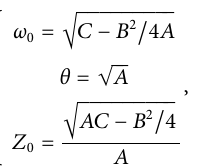
near the focal point. Again, using the combination ② + ⑥ as an example, the spot image taken near the focal point is shown in Figure 2D. Combined with the spot position, the focused laser transmission can be represented by fi tting the hyperbolic equation: